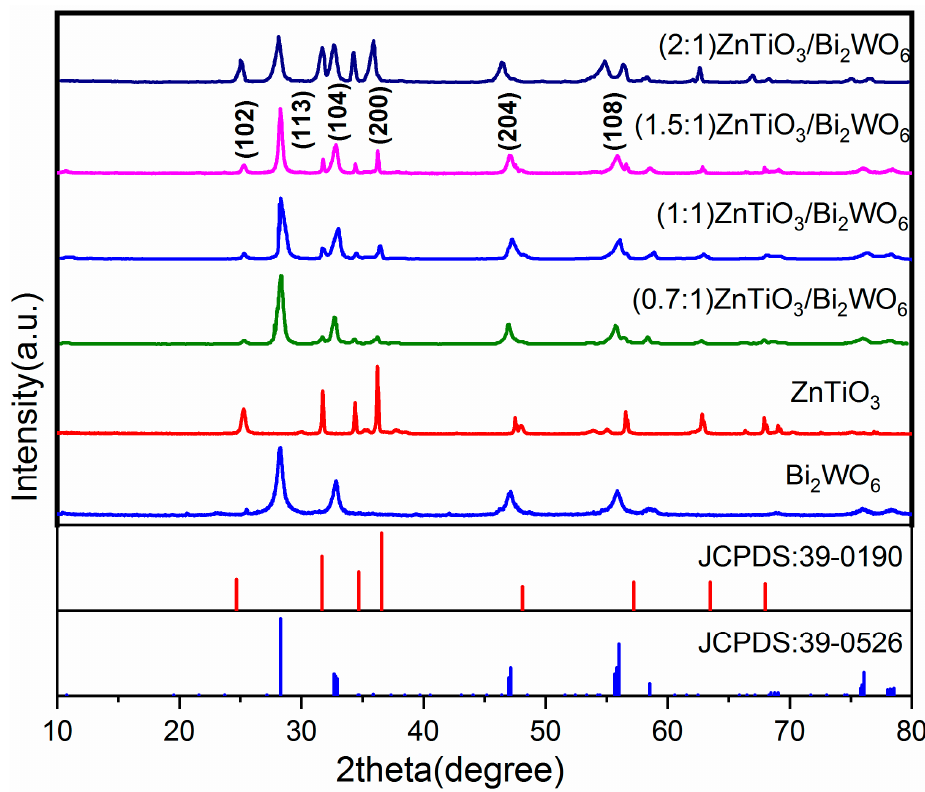
Figure 1. XRD pa tt erns of pure ZnTiO 3 , pure Bi 2 WO 6 , and the ZnTiO 3 /Bi 2 WO 6 heterojunction. Figure 1. XRD patterns of pure ZnTiO 3 , pure Bi 2 WO 6 , and the ZnTiO 3 /Bi 2 WO 6